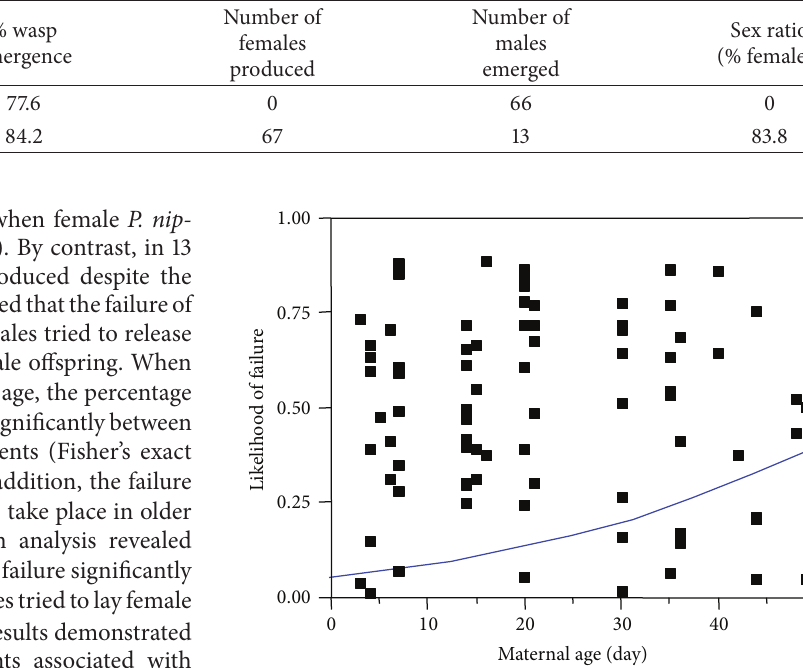
Table 1: Accuracy of abdominal tip movements for predicting the sex of offspring produced.